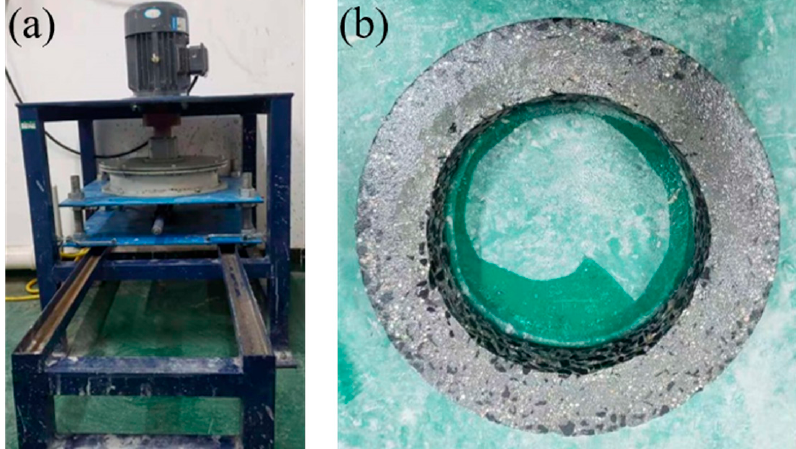
Figure 2. ( a ) Abrasion tester, and ( b ) specimen. .